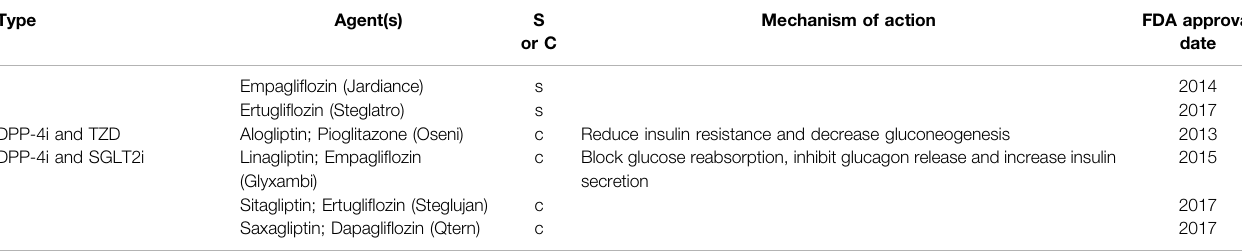
TABLE 1 | ( Continued ) FDA-approved anti-diabetic agents.